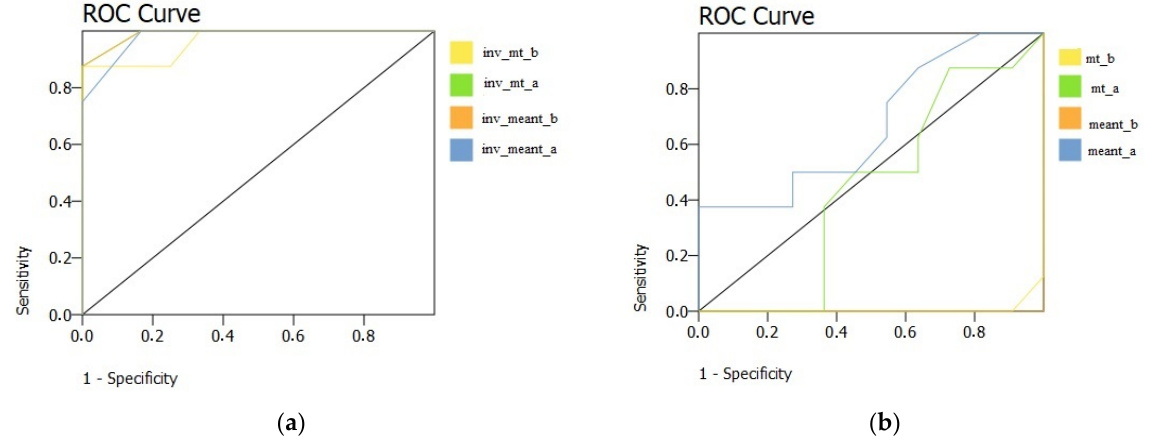
Figure 8. ( a ) Area under the curve (AUC) of the receiver operating characteristic (ROC) curve for frog surface showed the next values for the variants: inv_mt_b—inversion minimum